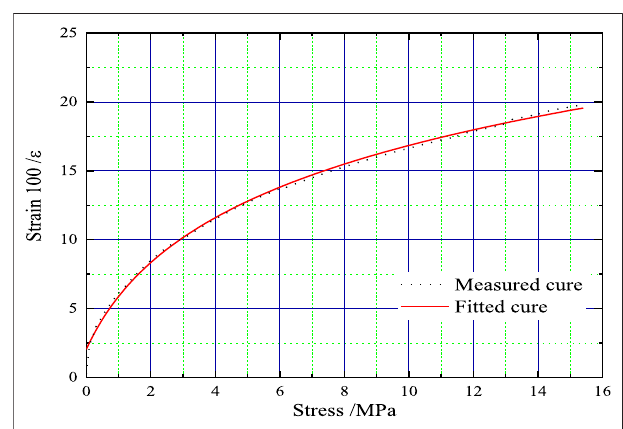
FIGURE 5 | Measured and fi tted stress – strain curves (washed gangue).